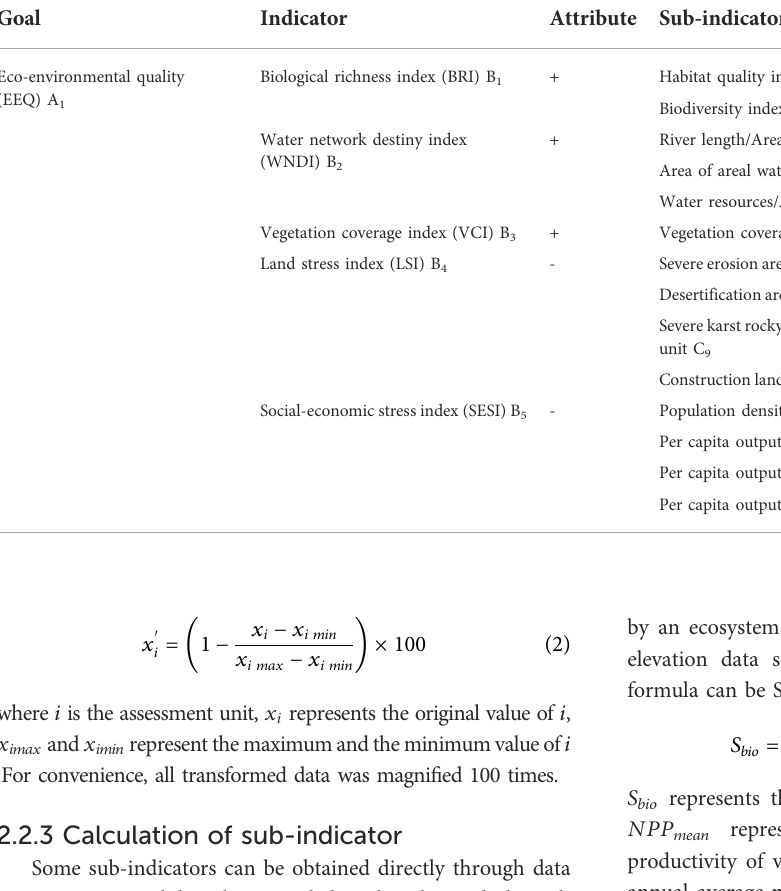
TABLE 2 Evaluation index